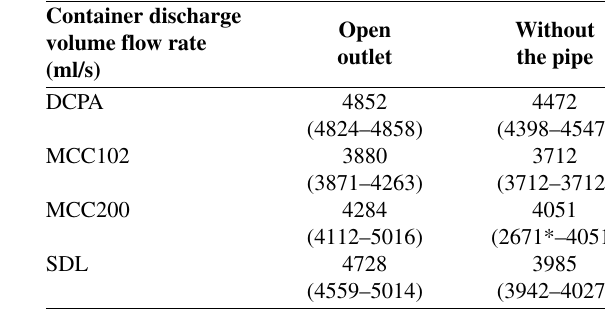
Jakli~ et al.: Granular Matter Transport in Vertical Pipes: ...